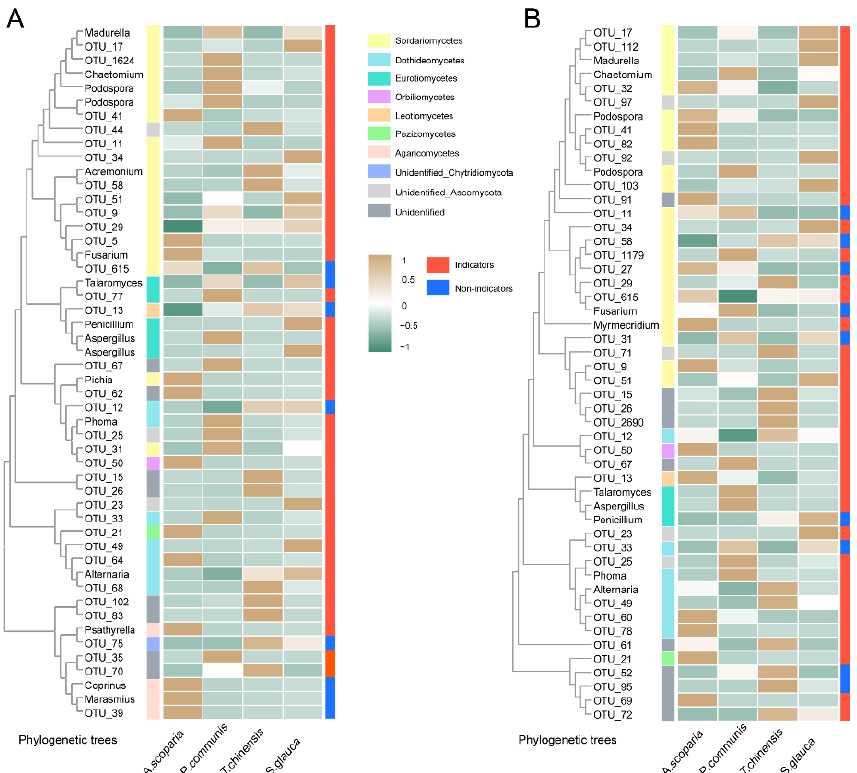
Figure 2. Phylogenetic clustering of the top 50 most abundant OTUs, and their relative abundance and indicator roles in the fungal community of the rhizosphere ( A ) and bulk soil ( B ). OTUs that could be affiliated to genus level are shown as genus; otherwise, they are shown as OTU_ID. The bars on the left indicated OTUs clustered at class level, and the bars on the right indicated whether the OTUs were indicators or non-indicators identified using indicator species analyses. The heatmaps in the middle showed the relative abundance of the